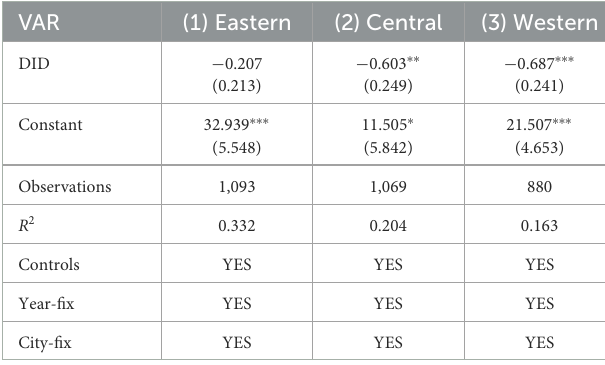
TABLE 5 Regional heterogeneity